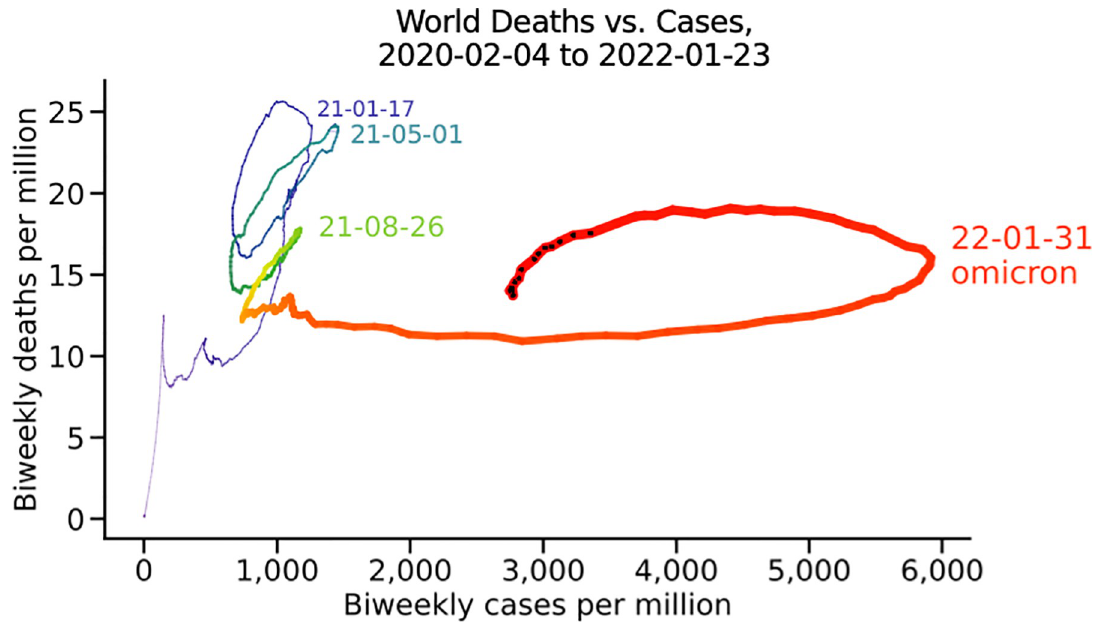
Fig 8. The world. All reported cases and